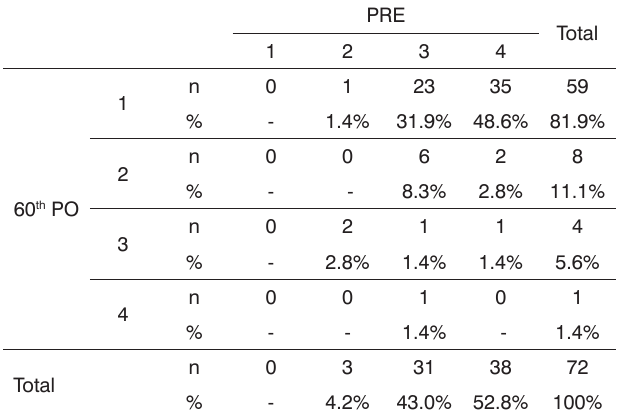
Table 1. Absolute and relative frequency of patients with nasal obstruction in the preoperative (Pre) and postoperative (60º PO) periods according to the degree of